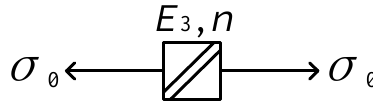
Figure 9. Nonlinear element.